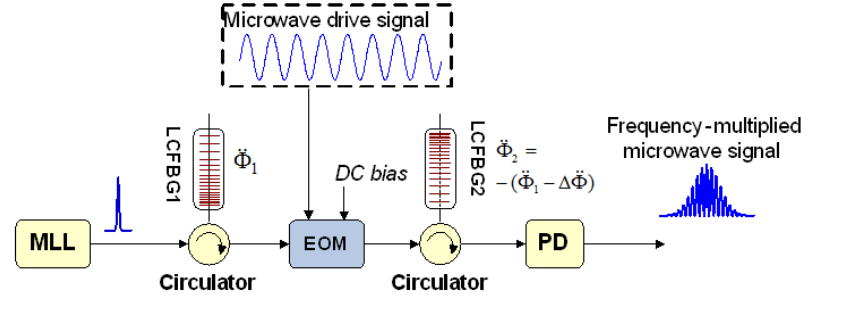
Figure 9. Schematic an unbalanced TPS system for microwave arbitrary waveform generation based on frequency multiplication. MLL: mode-locked laser, LCFBG: